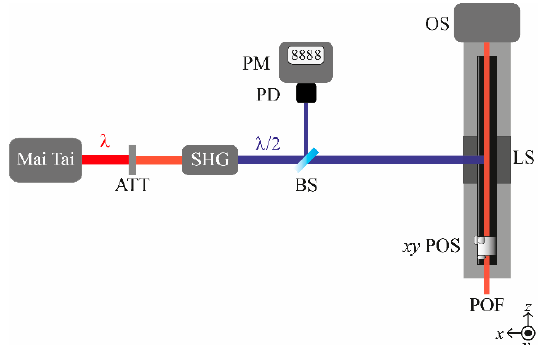
Figure 1. Experimental setup employed to measure the emission spectra of our doped POFs. Legend: ATT: variable attenuator; SHG: Inspire Blue second harmonic generator; BS: beam splitter; PD: photodetector; PM: power meter; LS: linear stage; xy -POS: xy-micropositioner; OS: optical spectrometer.